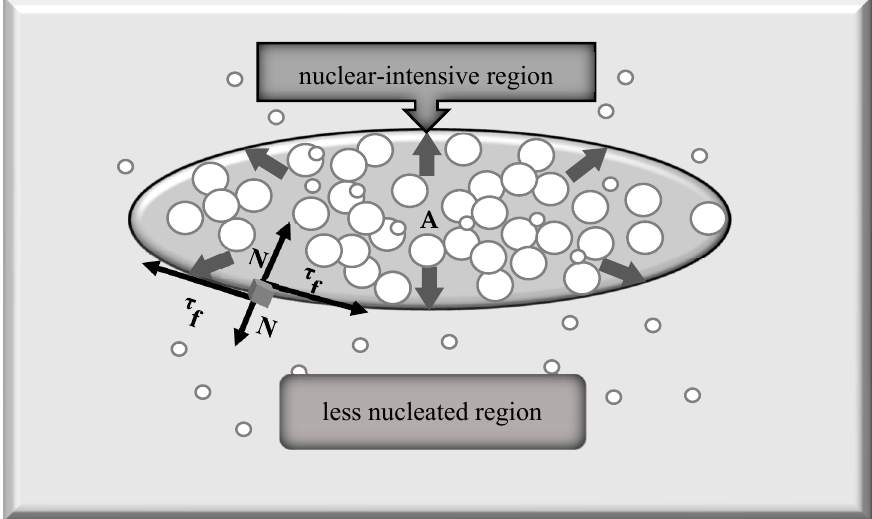
Figure 7. The schematic for the formation of shear stress.